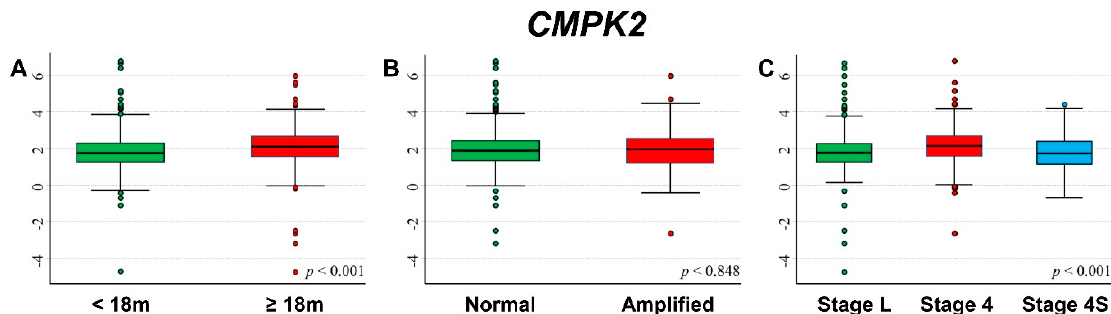
Figure 10. Association between CMPK2 gene expression and the main patient characteristics at diagnosis. ( A ) Age; ( B ) MYCN status; ( C ) Stage.